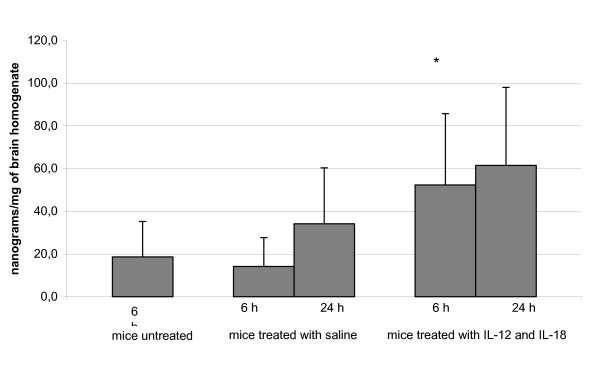
TNF-α production. TNF-α production detected in brain homogenates, from untreated mice or mice intracerebrally inoculated with saline or IL-12 and IL-18, sacrificed at different time after treatment. *values statistically different from those obtained in mice treated with saline at the same time